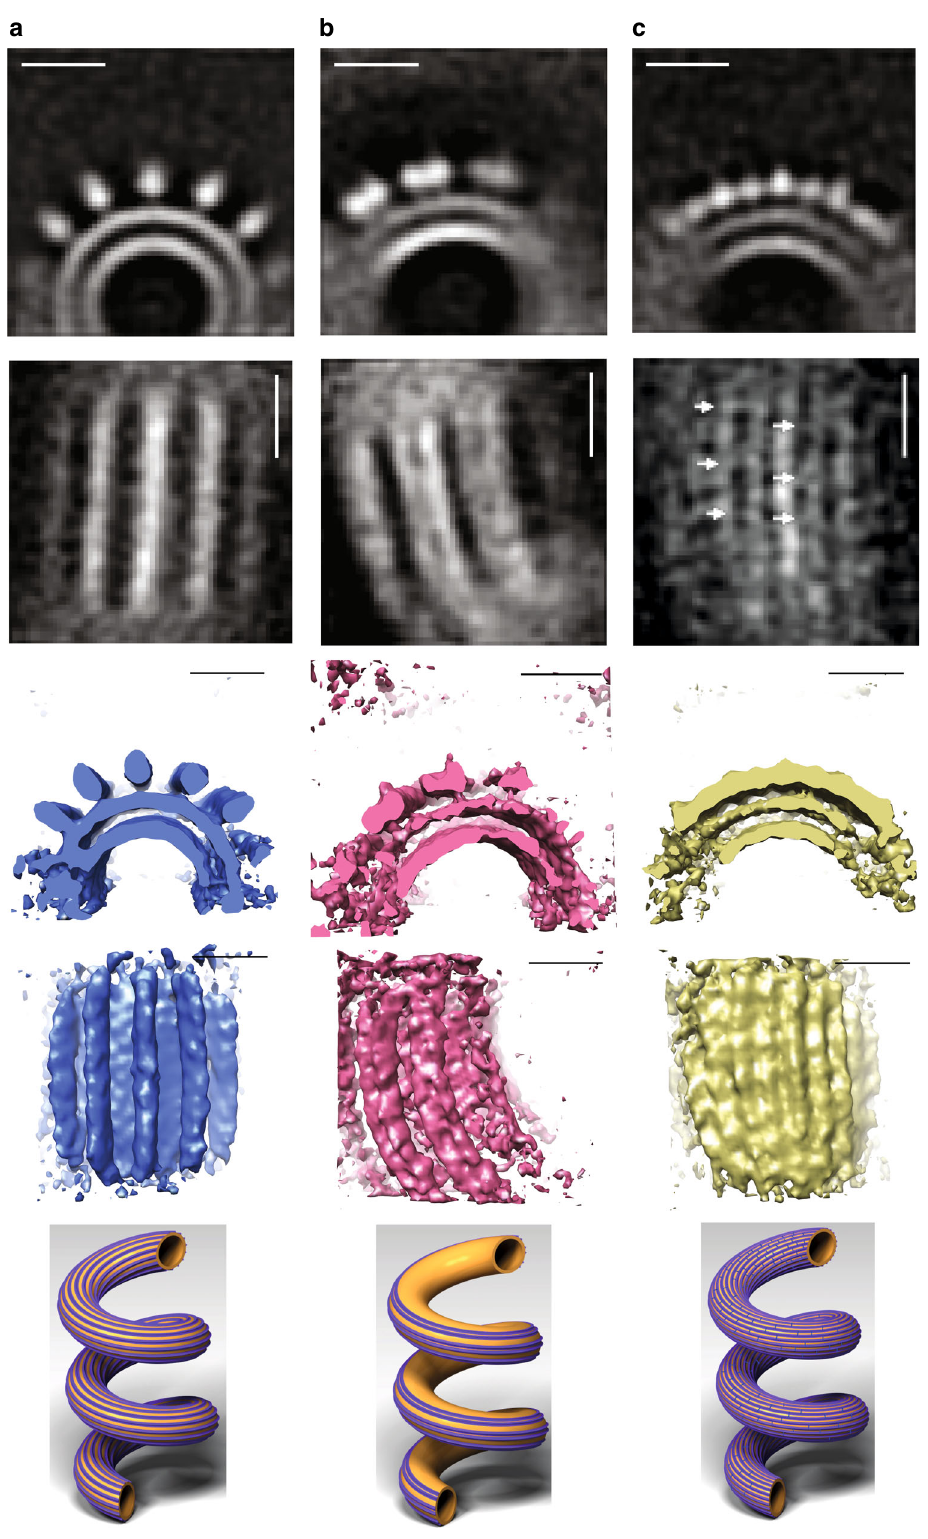
Fig. 4 Sub-tomogram averaging of CHMP4B- Δ C/CHMP2B- Δ C decorated pipes. Populations of ESCRT fi laments bound to tubular membranes resulting from sub-tomogram averaging. Upper line: orthoslices viewed from the cross sections of tubes. Second line: orthoslices viewed from the top of tubes. Third line: 3D reconstructions viewed from the cross sections of tubes. Fourth line: reconstructions viewed from the top of tubes. Bottom line: schematic representations of the CHMP4B- Δ C/CHMP2B- Δ C-decorated pipes. Scale bars: 10 nm. a Single ESCRT individual fi laments bound to lipid tubes. Inner tube diameter: 14.8 nm, outer tube diameter: 21.7 nm. Protein density diameter: 30.2 nm. Reconstruction from 1721 particles. b Paired ESCRT fi laments bound to lipid tubes. Inner tube diameter: 15.4 nm, outer tube diameter: 21.7 nm. Reconstruction from 524 particles. c High density of fi laments bound to lipid tubes. Inner tube diameter: 18.5 nm, outer tube diameter: 25.4 nm. Reconstruction from 381 particles. Arrows point to structures perpendicular to the tube